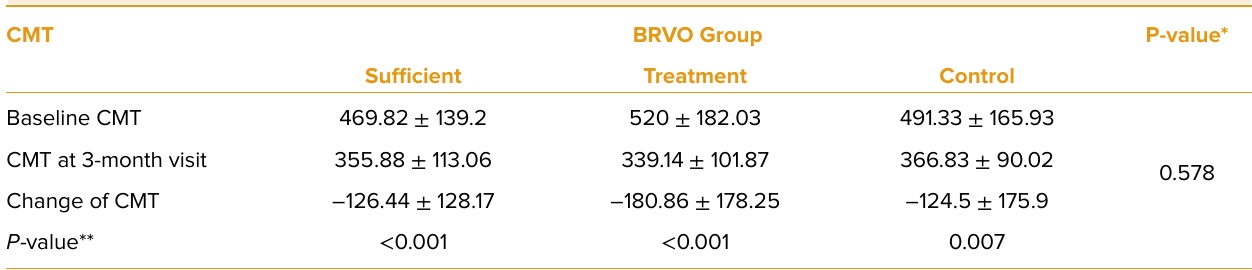
Table 3. Changes of CMT following IVB in BRVO subgroups.